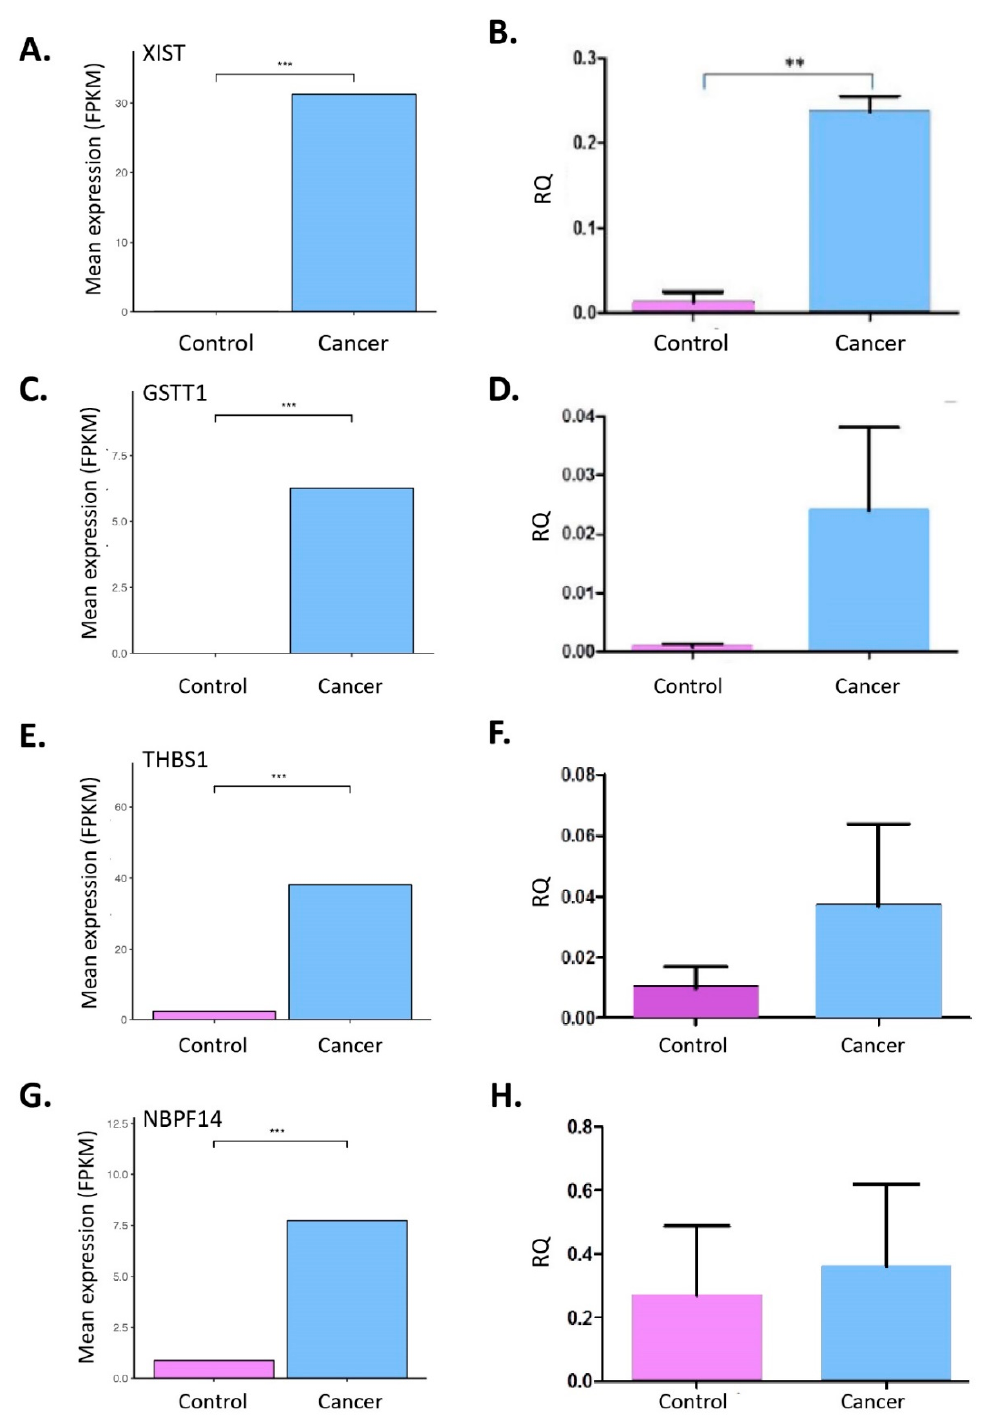
Figure 4. ( A , C , E , G ) show gene expression in blood samples from LC patients vs. control. Mean expression level is show in FPKM units, and was calculated using CuffDiff. (*** p < 0.001 computed using CuffDiff). ( B , D , F , H ) show qRT-PCR expression for XIST, GSTT1, THBS1 and NBPF14 respectively. Validation data shows the similar up-regulation of genes’ expression in patient blood samples compared to controls. ** p < 0.01